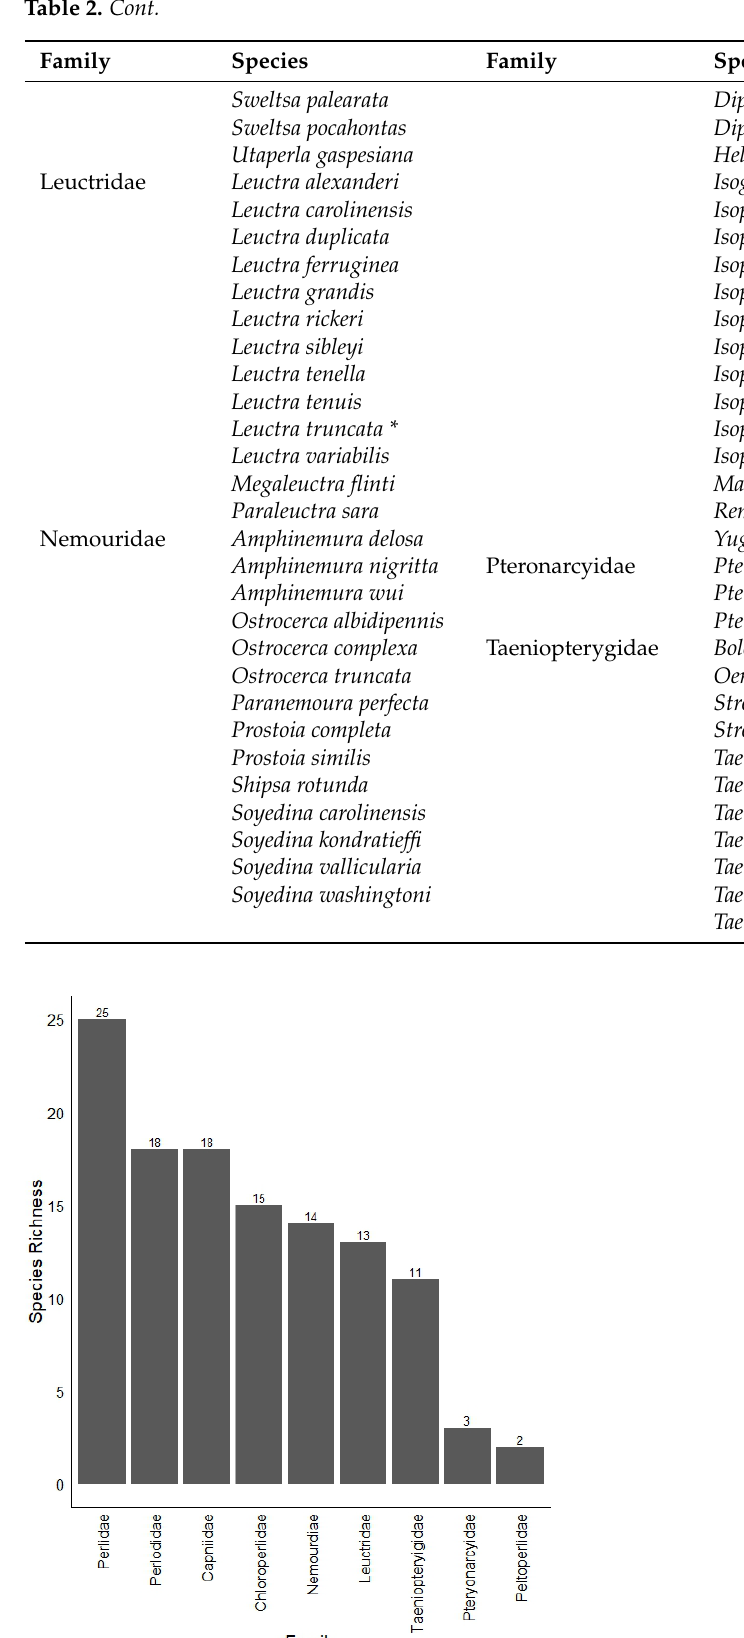
Figure 3. Species richness among stoneflies families represented in